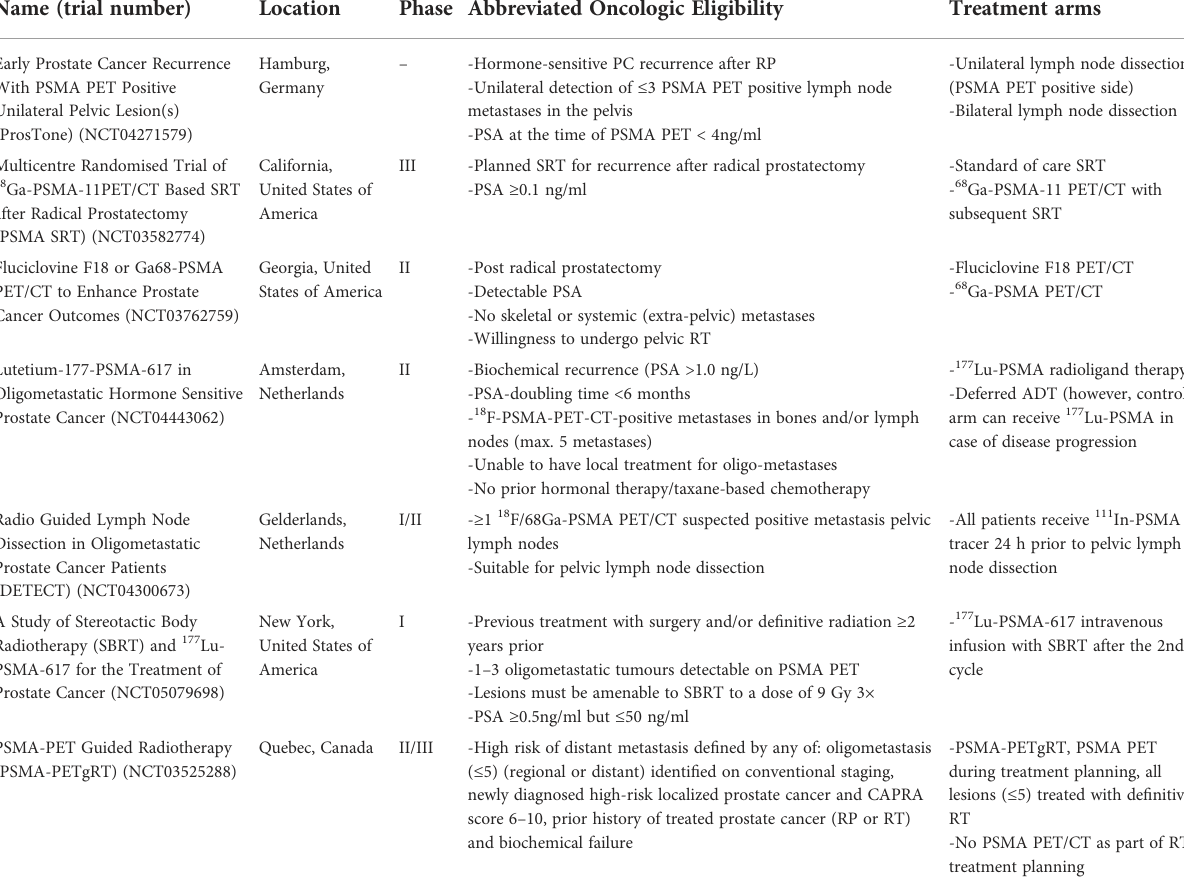
TABLE 2 Current active trials for PSMA PET-guided MDT in oligometastatic prostate cancer. Name (trial